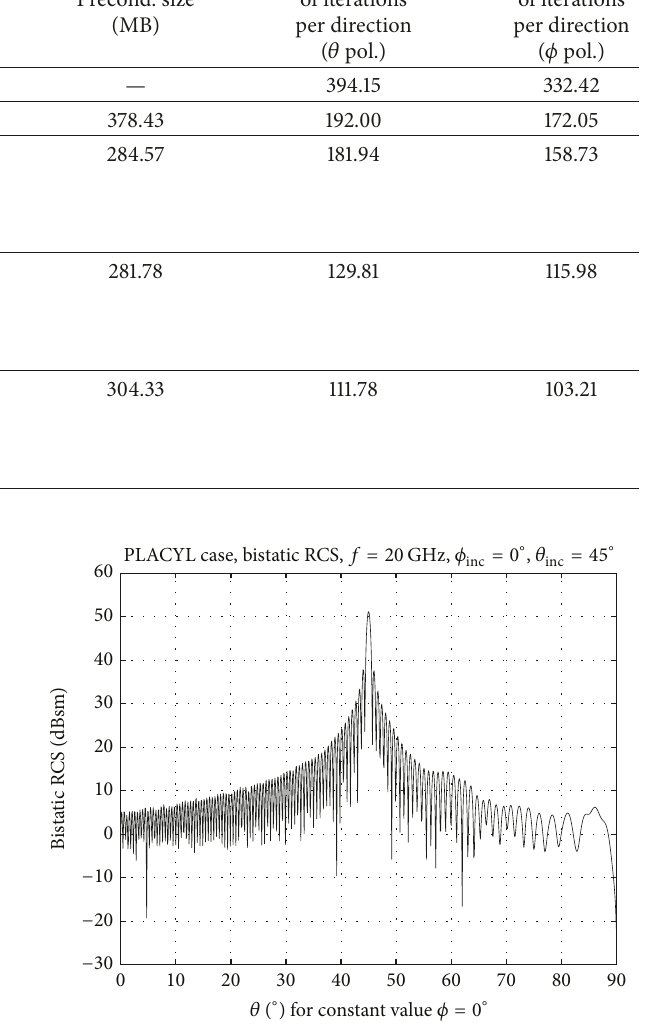
approximation with 𝜀 𝑟 = 4 . The wheels have been modeled by means of a thin layer approximation using 𝜀 𝑟 = 7 , and dielectric losses have been introduced by assigning the loss tangent tan (𝛿) = 0.04 , considering these values as a realistic approach for the rubber compound of the tires [24]. The size of the car is approximately 4.14 meters long, 1.64 meters wide, and 1.35 meters tall, which at the working frequency corresponds to 81.5 𝜆 tall, 32.25 𝜆 wide, and 26.55 𝜆 high. The bistatic RCS has been computed for a 𝜃 -polarized plane ∘ ∘ and 𝜙 = 45 . The observation wave impinging from 𝜃 = 80 ∘ angular cut 𝜃 ranging directions are contained in the 𝜙 = 45 from 0 ∘ to 90 ∘ in 0.1 ∘ steps. The EFIE formulation has been applied, due to the geometrical and material features of this problem. Figure 7 shows the computed results. Convergence has been obtained for an error of 10 −3 in 281 iterations. Realistic cases often offer a slow convergence due to the